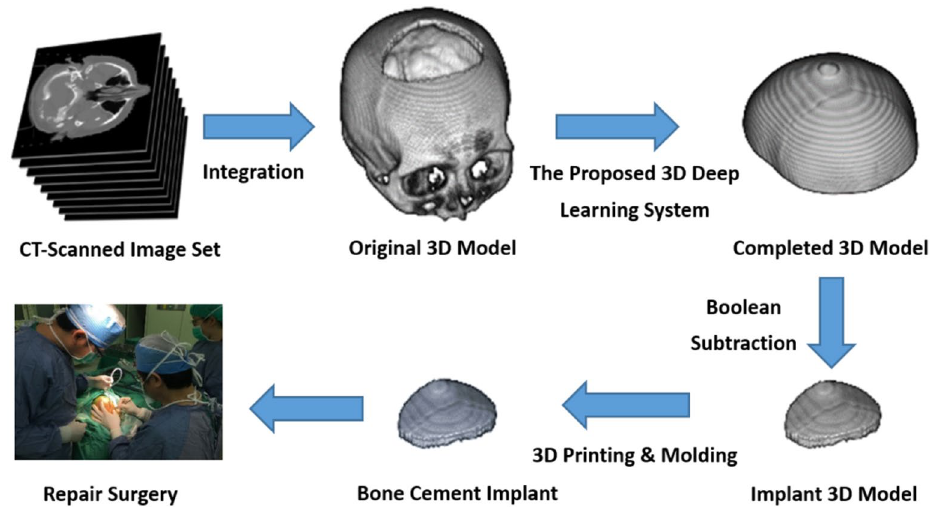
Figure 1. Cranial reconstruction surgery